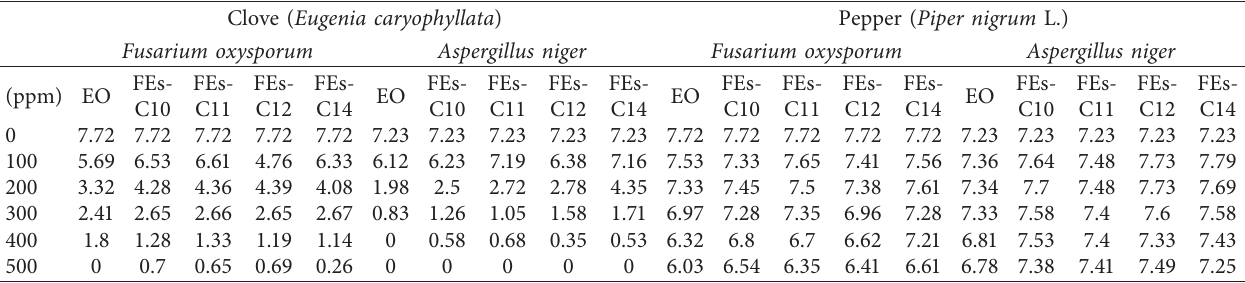
Figure 1: Colonies and microscopic morphology at 10x and 40x of Fusarium oxysporum (a, b) and Aspergillus niger (c, d) at 9 days of incubation on PDA agar. Table 3: Effects of essential oils (EOs) and functional extracts (FEs) of clove and pepper in vitro at various concentrations on radial growth of Fusarium oxysporum and Aspergillus niger